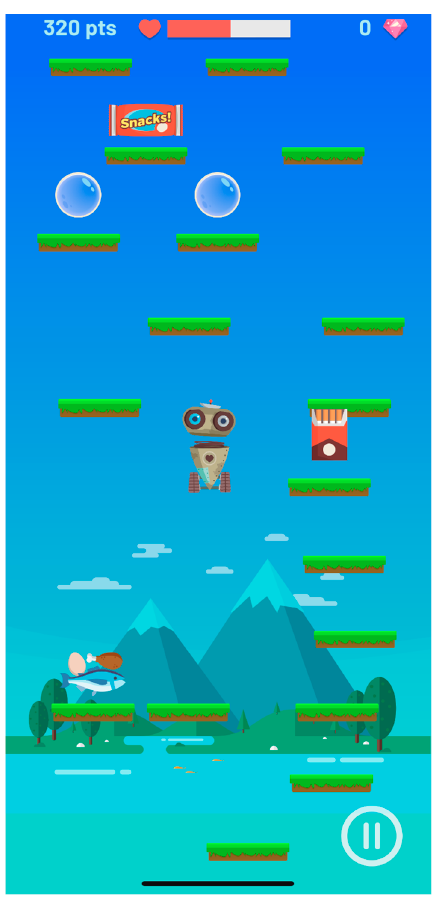
Figure 3. A game to work on healthy habits playfully.